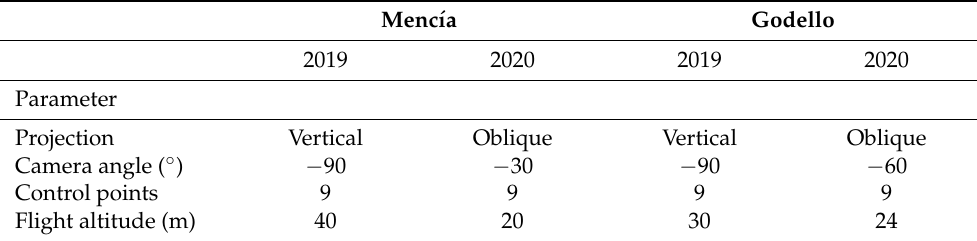
Table 1. Flight parameters per vineyard and season.